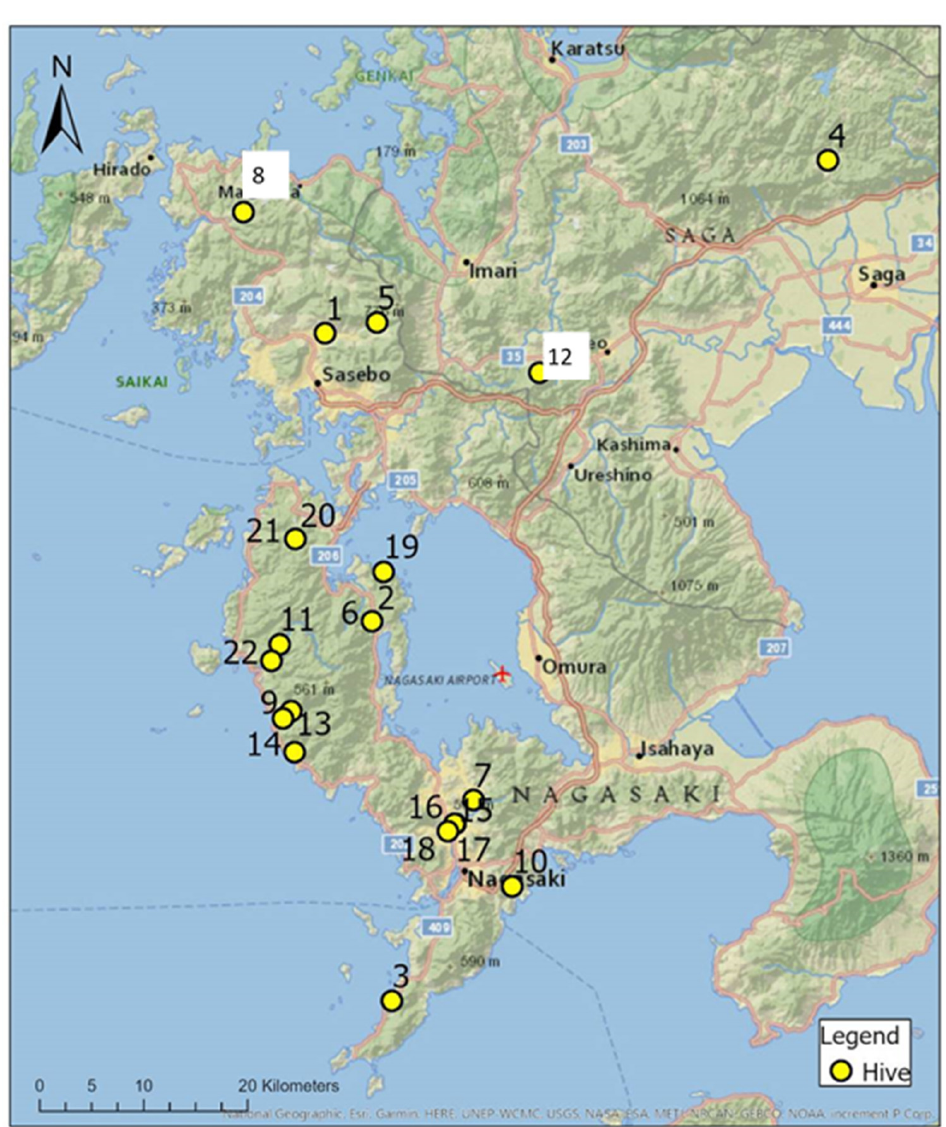
Figure 1. Locations of 22 hives from which honey samples were collected, clustered hive locations (Hives 7, 15–18) are also available in Supplementary Appendix 1.